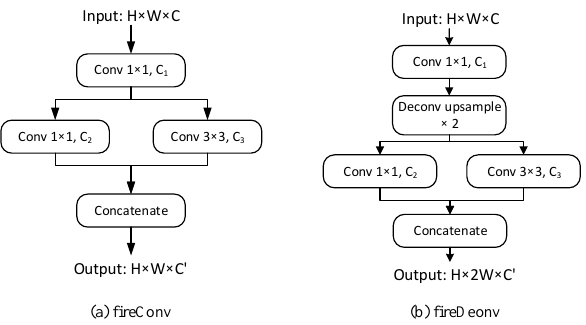
Figure 3. The structure of fireConv and fireDeconv from SqueezeNet.